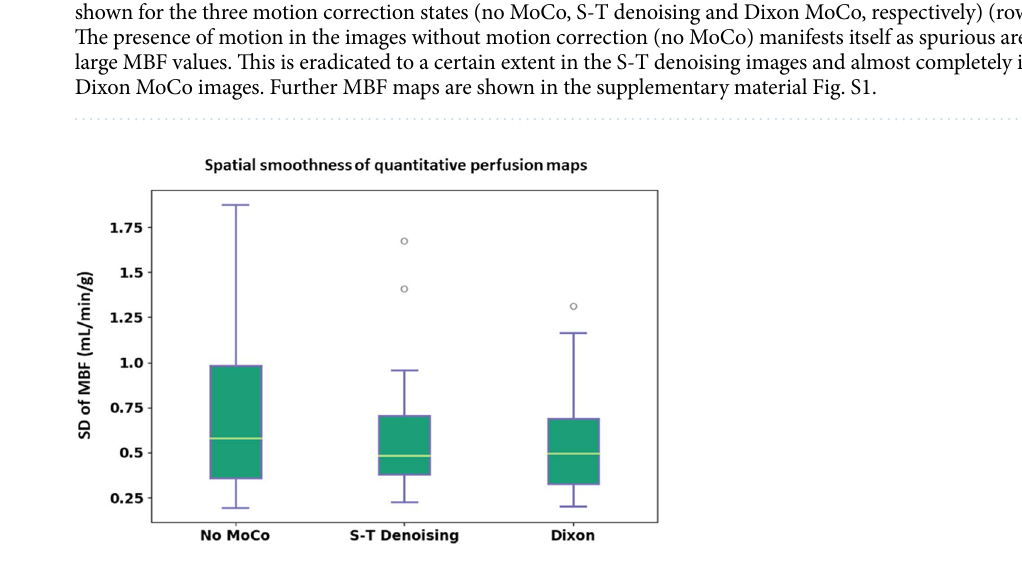
Figure 7. The distribution of the MBF spatial uniformity metric for the three motion correction states. The quantitative MBF maps become more uniform after motion correction due to the eradication of the motion- related artefacts in the myocardial time-intensity curves. Similar performance is reported for the S-T denoising and Dixon MoCo images with both being significantly more uniform that then no MoCo